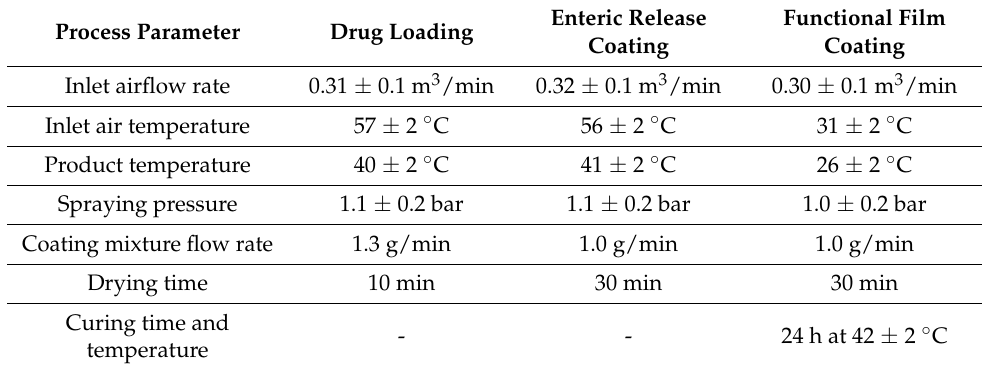
Table 1. Summary of process parameters used during pellet coating.